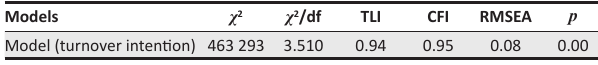
FIGURE 1: Organisational commitment mediation over all models. SE, standard TABLE 3: Goodness-of-fit statistics for structural model.